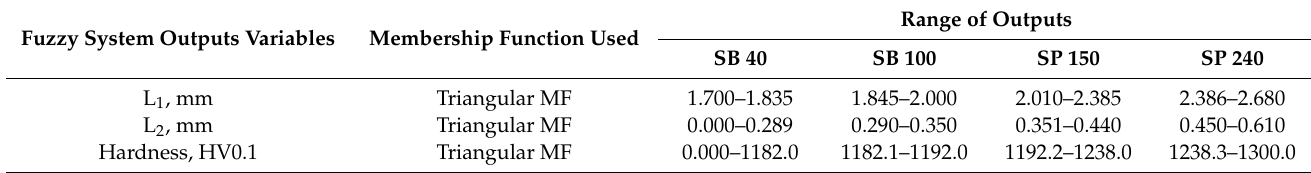
Table 4. Membership functions of fuzzy system outputs.